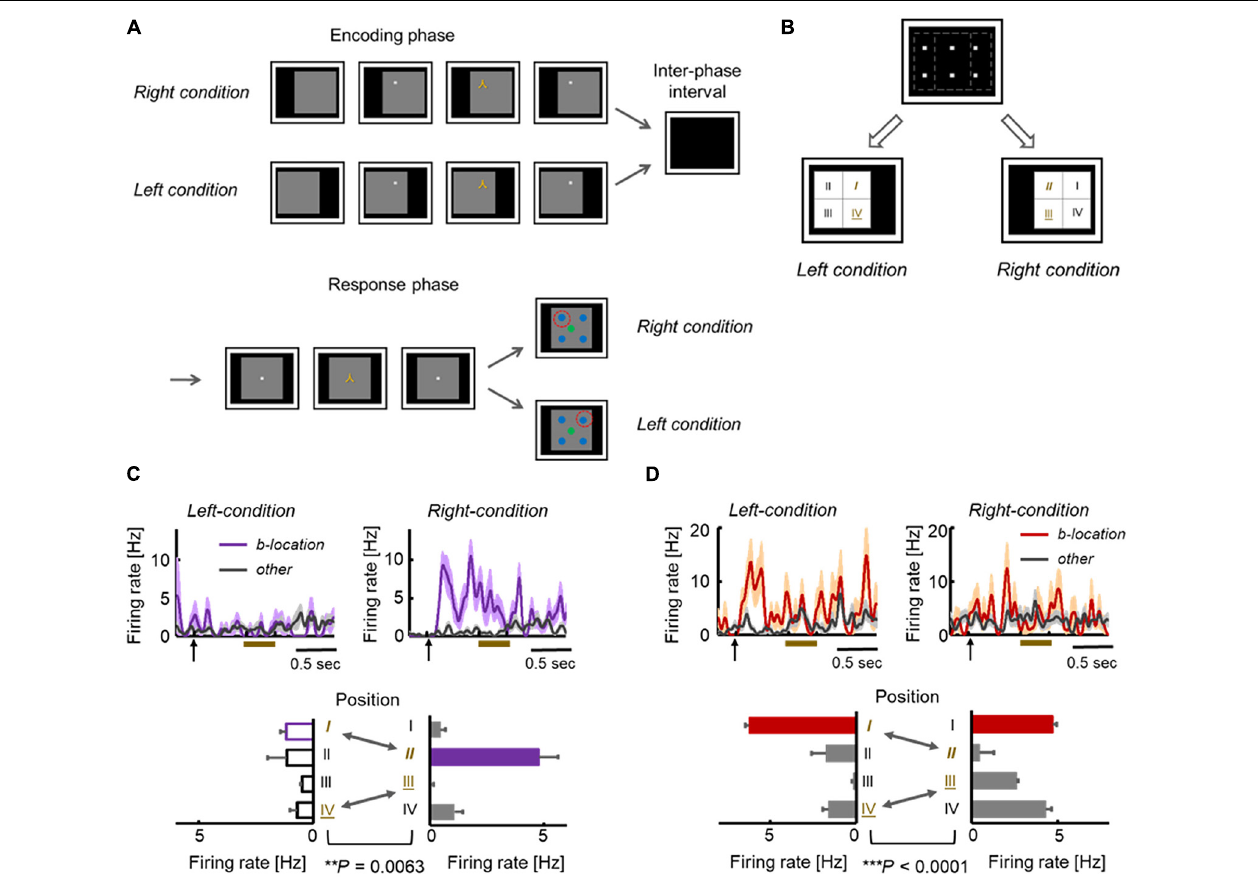
FIGURE 4 | Location-selective responses in conditional-type ILR Task. (A) Sequences in the conditional-type ILR task showing the left and right conditions. The time parameters are the same as those in the standard ILR task, except for the initial presentation of the gray square (0.5 s). (B) Spatial configuration of the stimulus positions in the left and right conditions. The first and fourth quadrants in the left condition (“I” and “IV”) were also used as the second and third quadrants in the right condition (“II” and “III”). (C) Example of an HPC neuron in which responses to the same fixation position differed between the two conditions. (D) Example of a TE neuron showing significantly different responses between the two conditions. Adapted with permission from Chen and Naya